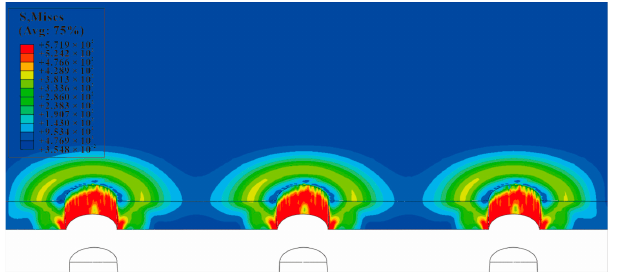
Figure 12. Equivalent von Mises stress of each hole along the x -axis of a three-hole cold-expanded specimen with a hole spacing of three times the diameter of the hole.